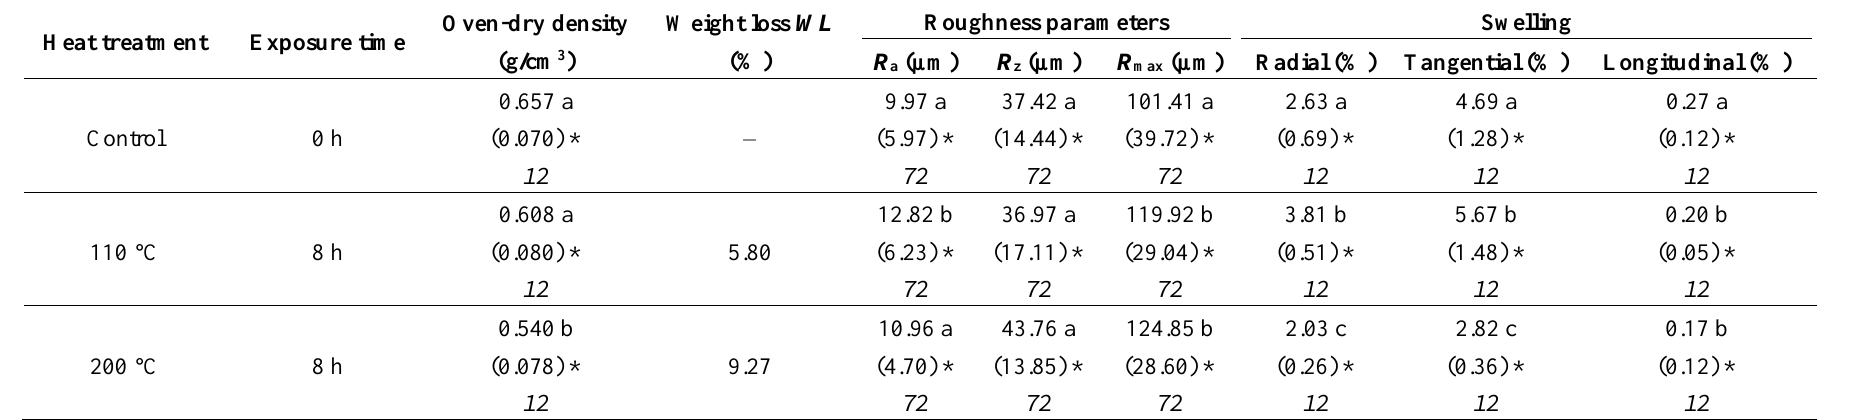
Table 1. Test results of heat-treated red oak specimens.